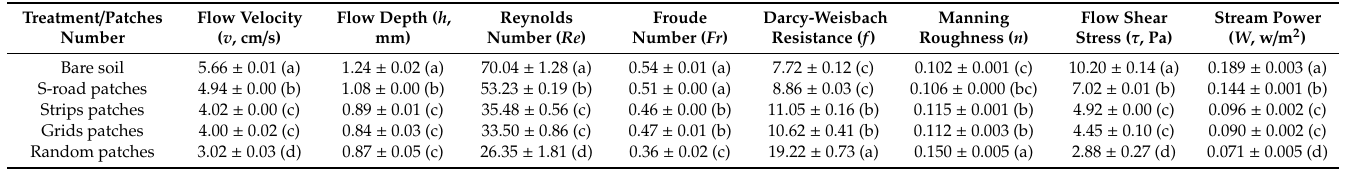
Table 4. Flow hydrodynamic parameters for di ff erent types of vegetation patches under simulated rainfall.